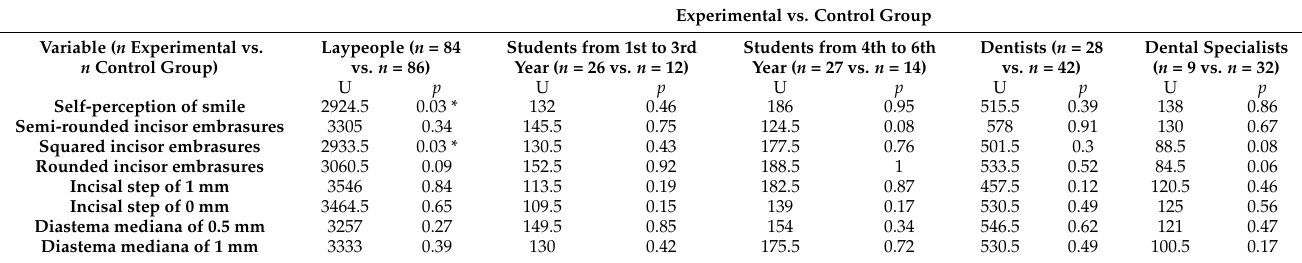
Table 5. The differences between the experimental and control groups by individual occupations in the second